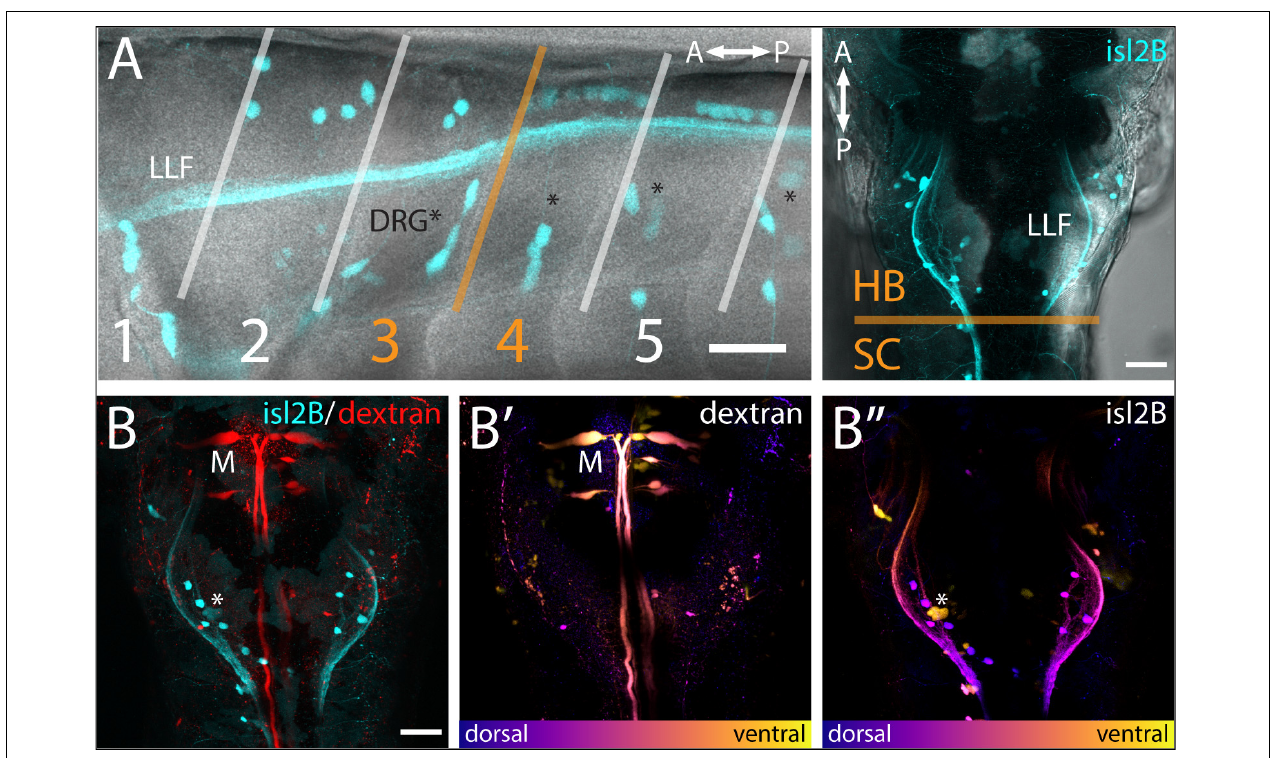
FIGURE 2 | FSNs have somas in the hindbrain and spinal cord. (A) Left panel: Brightfield and fluorescent merged image adjacent to myomeres one through five, indicating the distribution of the islet2B + somas (cyan) innervating the fin. The FSN somas innervating the fin are located dorsal to the dorsal root ganglion (DRG) neurons visible as clusters (asterisks). Fibers from DRGs also projected to the fin at this stage, but they cannot be traced individually. The lateral longitudinal fasciculus (LLF) extends from the hindbrain into the spinal cord. The transition area between myomeres three and four, historically referred to as the transition between the hindbrain and spinal cord, is indicated in orange. Cells posterior to the boundary are located in the spinal cord, and islet2B + cells in this location are Rohon-Beards. Right panel: Brightfield and fluorescent merged image of a dorsal view of a Tg[islet2B:GFP] fish. The hindbrain and spinal cord boundary is again marked in orange. The organization of the sensory neurons along the lateral margins of rhombomere 7/8 is bounded by the LLF. (B) All of the somas (cyan, left panel) are located posterior to the Mauthner neurons (red, M). Additionally, Mauthner neurons are notably more ventral ( B (cid:48) , M) in the hindbrain than the FSNs ( B (cid:48)(cid:48) , asterisk is DRG). Anterior is to the left, dorsal is up in ( A left panel). Anterior is up, dorsal view in ( A right panel and B ). Scale is 40 microns in ( A left panel) and 50 microns in ( A right panel and B ).